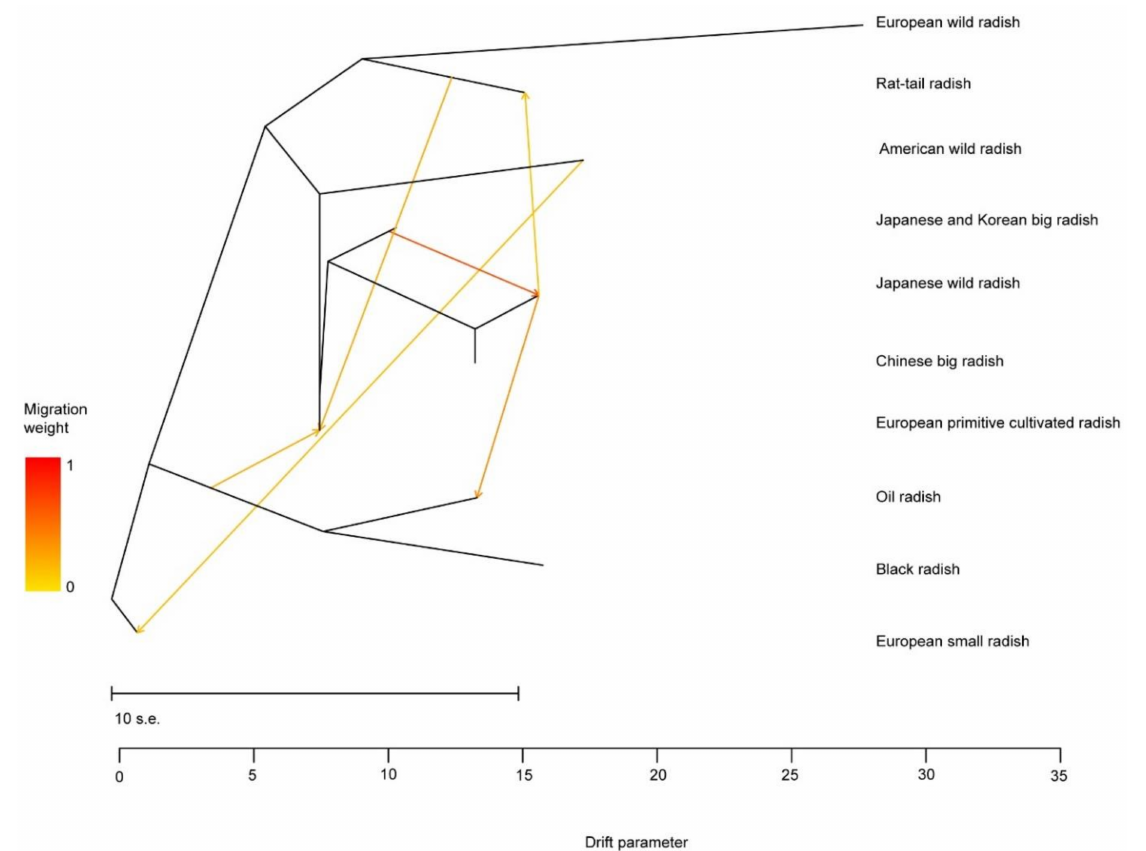
Figure 4. Gene flow among different cultivated and wild radish populations. The color of the bar shows the migration weight, and the arrows indicate the direction of gene